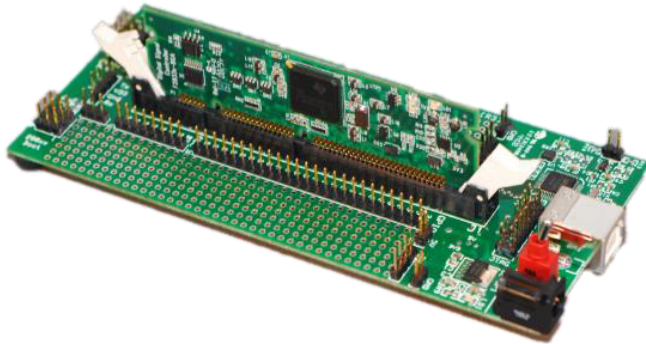
Figure 15. Docking station with control board and DSP.